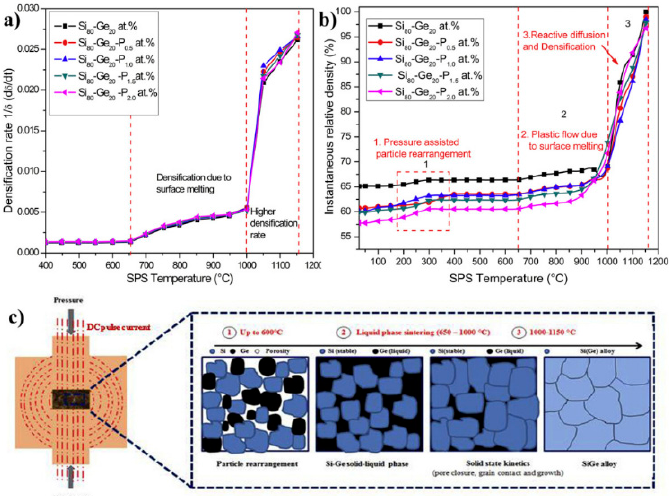
Figure 11. Si-Ge powder ( a ) densification rate, ( b ) instantaneous relative density during SPS, and ( c ) schematic representation of alloying in SPS. Reproduced with permission from reference [84].